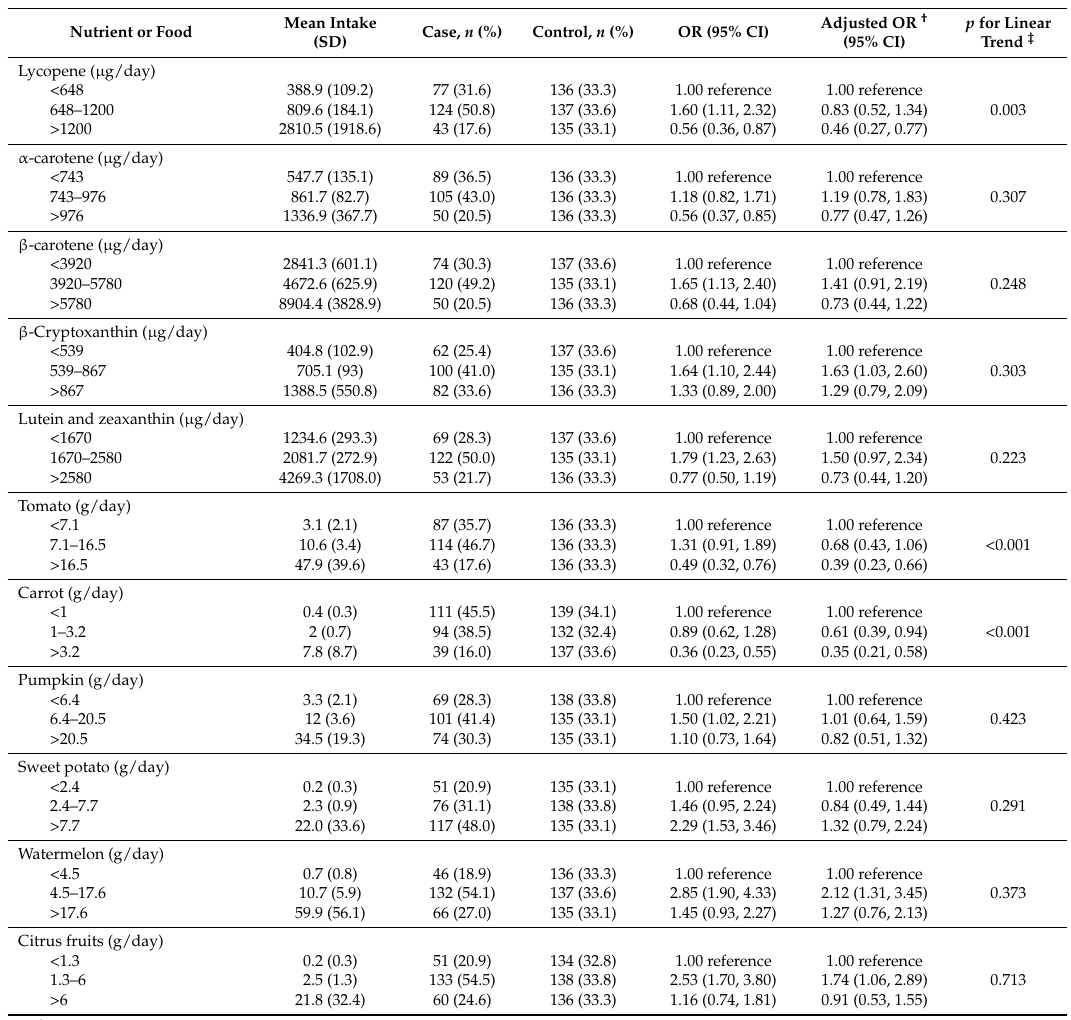
Table 3. Crude and adjusted odds ratios and associated 95% confidence intervals of prostate cancer risk for the intakes of carotenoid and their